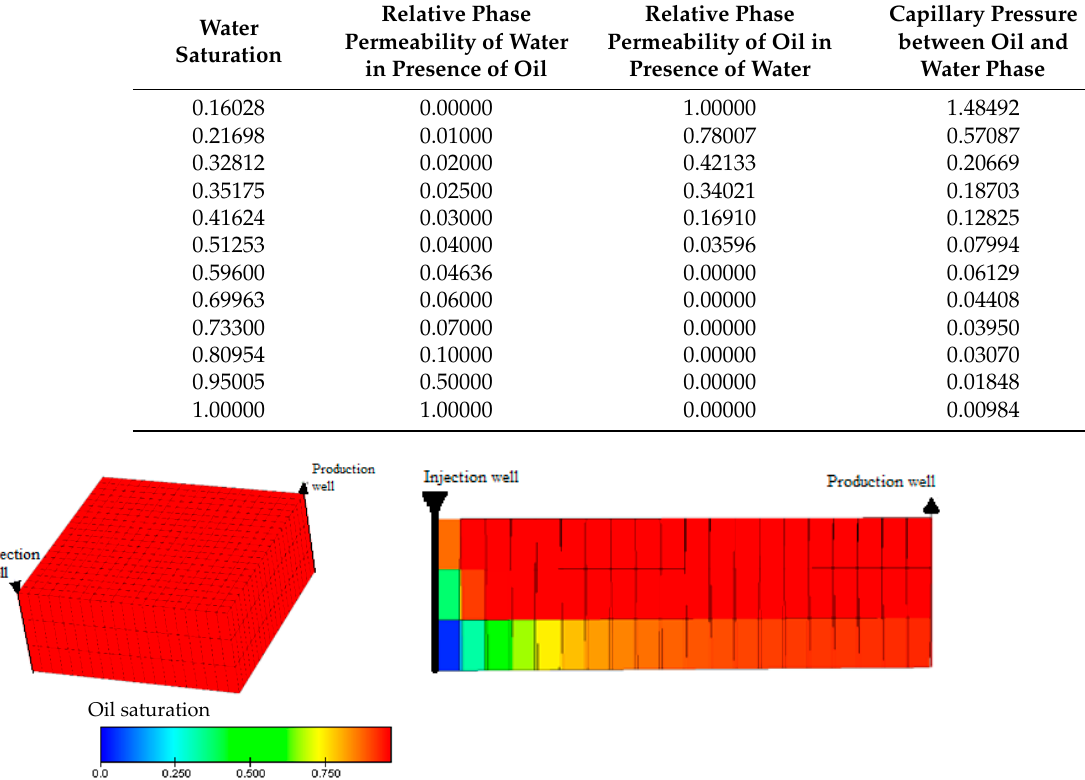
Table 4. Relative phase permeabilities in the oil–water system (variant 1).